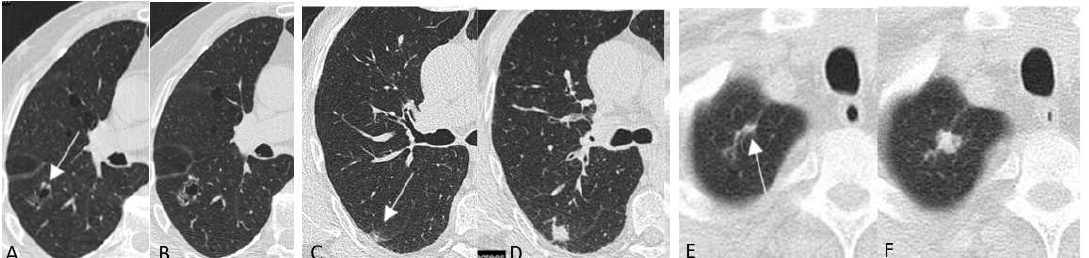
Figure 2. ( A – F ) Non-nodular presentations of lung cancer and precancerous lesions in chest low- dose CT screening in three subjects. Lung cancer associated with cystic airspace (arrow) at baseline LDCT ( A ) and two years later ( B ); lung cancer presenting as perifissural abnormality (arrow) at baseline LDCT ( C ) and appearing as solid nodule 2 years later ( D ); lung cancer presenting as scar-like abnormality (arrow) at baseline LDCT ( E ) and appearing as a solid nodule 1 year later ( F ). All images reproduced modified from Mascalchi et al.